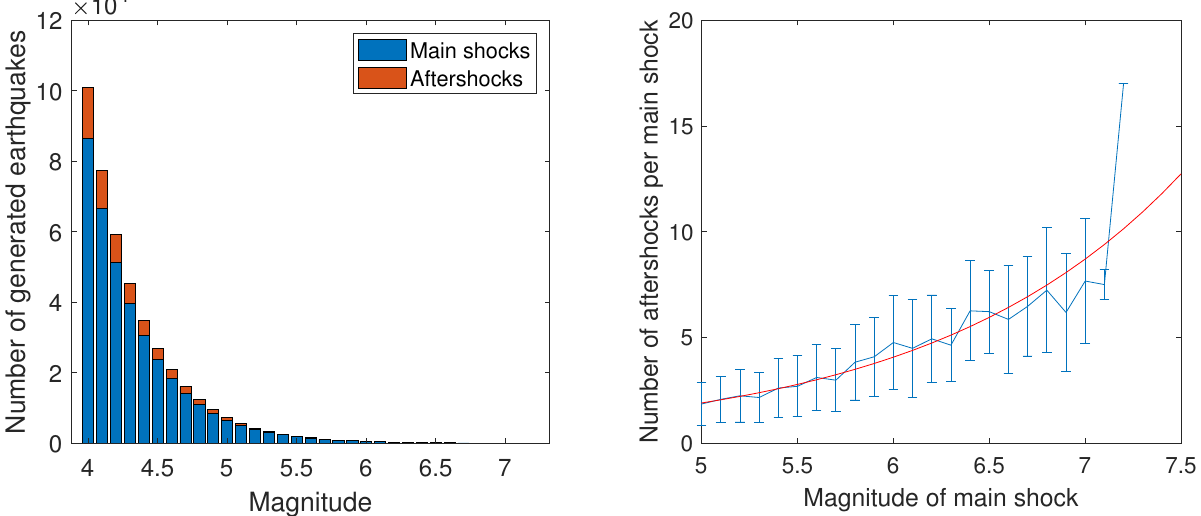
Figure 13. Number of aftershocks produced over 100,000 years by using the PMD estimated from the exhaustive historical French catalogue (FCAT-17). ( Left ): Number of main shocks and aftershocks as function of magnitude. ( Right ): Number of aftershocks produced by one main shock according to magnitude of the latter. Red line represents the regression of Equation (13) on these results: k = 0.887 and α =